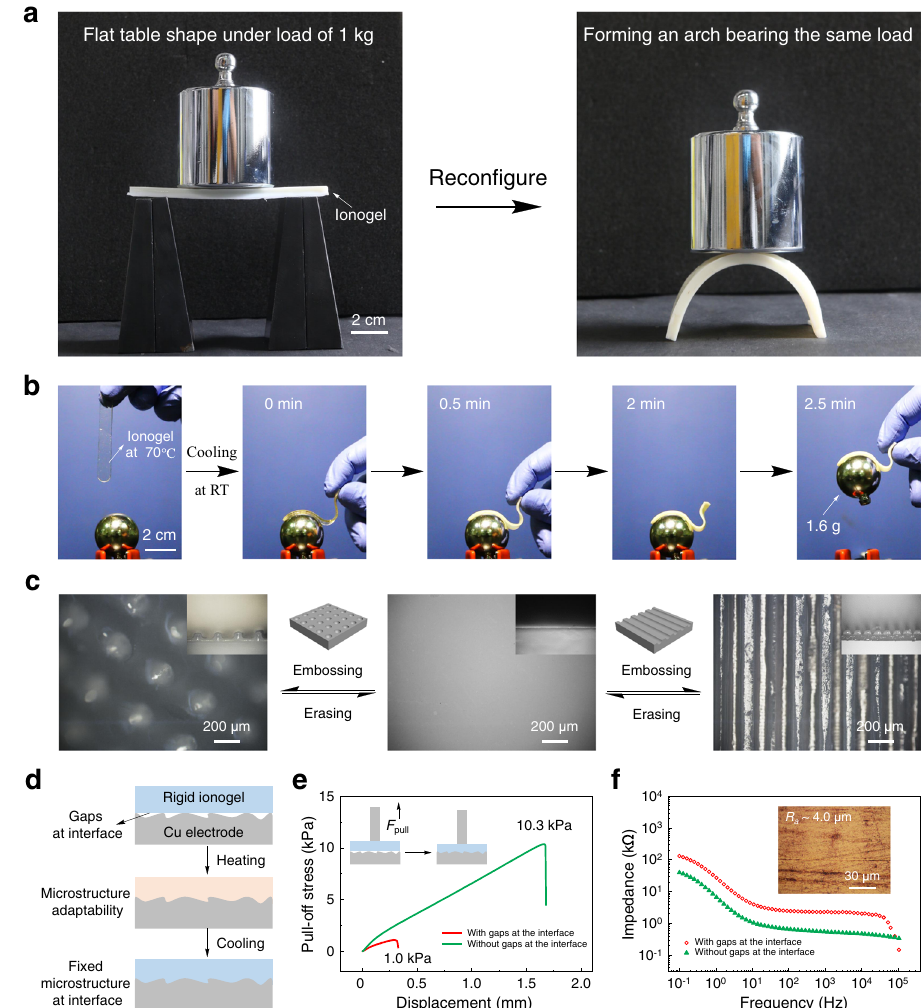
Fig. 4 | Shape recon fi gurability and microstructure adaptability of PNIPAm ionogels. a Photographs showing the load-bearing capability and the shape recon fi gurability of phase-separated PNIPAm ionogel. b Photographs showing the soft-to-hard transitional contact of PNIPAm ionogels. c Demonstration of the microstructure adaptability of PNIPAm ionogels. The semi-spherical pattern (left) and the ribbon pattern (right) were embossed by fi xing the microstructure of substrate, which can be erased and recovered to the smooth original pattern